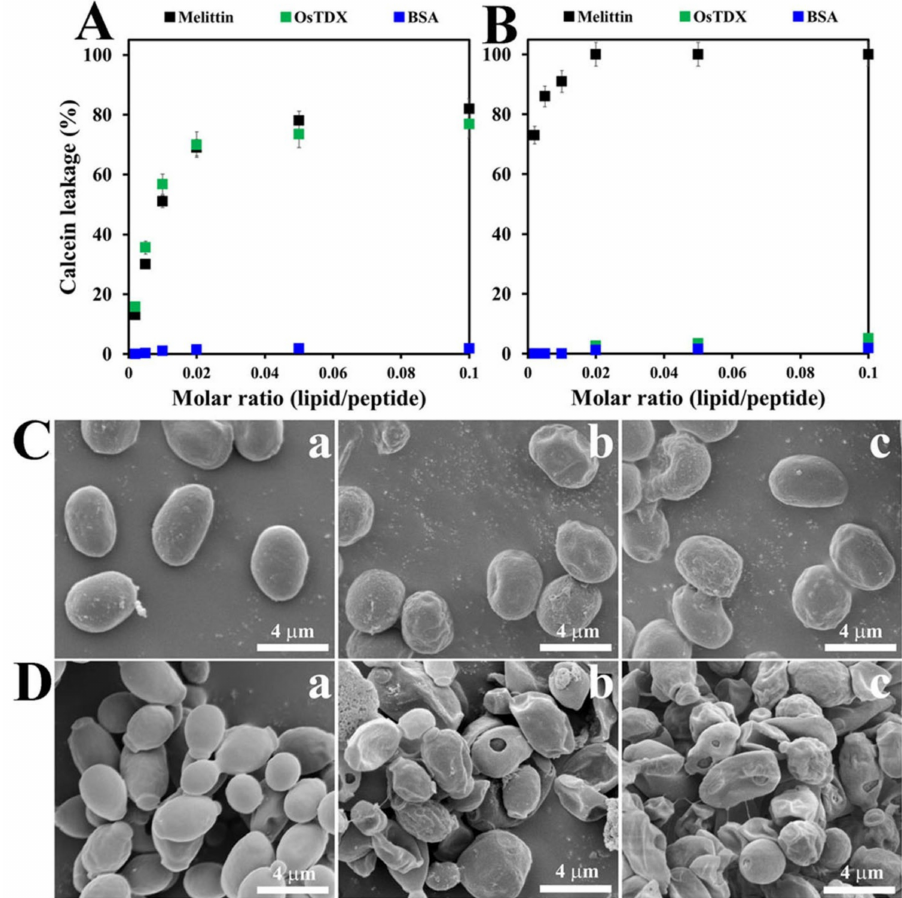
Figure 5. Membrane-permeabilizing activity of OsTDX in fungal cells. ( A , B ) Calcein-entrapped liposomes composed of PC/PE/PI/ergosterol (fungal membrane, 5:4:1:2, w / w / w / w , A ) or PC/Ch/SM (mammalian membrane, 1:1:1, w / w / w , B ) lipids were prepared, and liposome suspensions of 100 µ M were incubated with indicated samples. The fluorescence of the released calcein was measured using a fluorescence spectrofluorometer, and 100% release was achieved using 0.03% Triton X-100. ( C , D ) Scanning electron micrographs of Candida gloeosporioides ( C ) or Candida albicans ( D ) cells treated with PBS buffer ( a , control), OsTDX ( b ), or melittin ( c ) at minimum inhibitory concentration